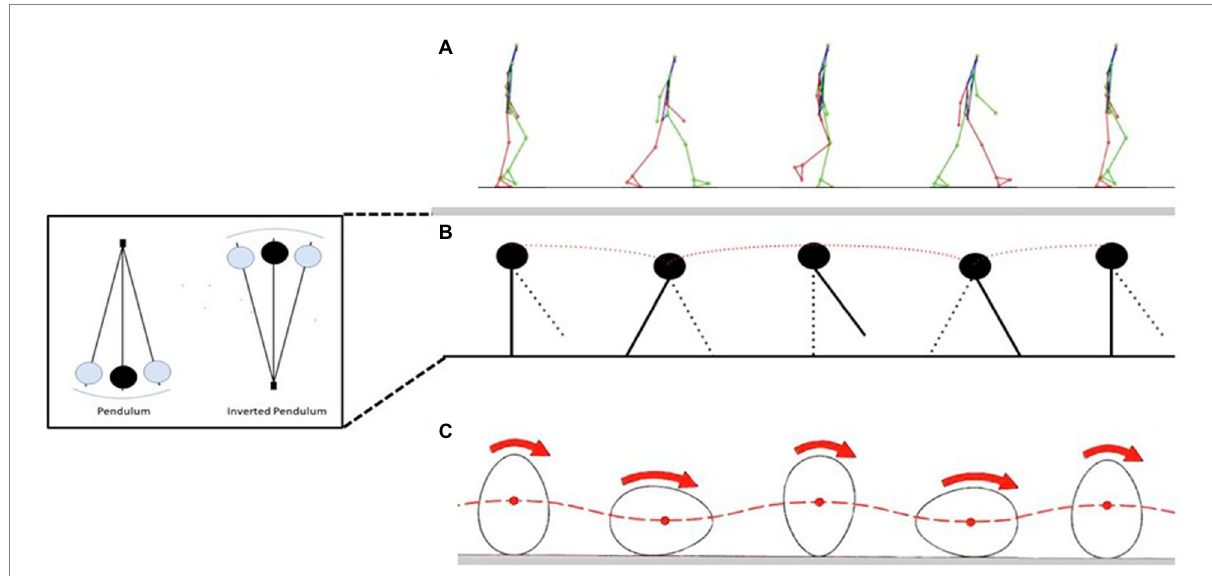
FIGURE 1 Gait cycle (A) depiction of the gait cycle from the single support of one foot to the next one. In the middle you can see: double support (second figure), single contralateral support and double support; when one limb is in single support, the other is in the swing phase. (B) “The inverted pendulum” the locomotor paradigm of the gait. The center of mass moves on arcs of circumference during the ground support phase as would a pendulum with a fulcrum on the floor (inset). In walking, the fulcrum on the ground is given by the foot, while the bar on which the center of mass is attached is the lower limb. The center of mass is at the apex of the trajectory during single support (the lower limb is extended and perpendicular to the ground), at the lower end during double support. (C) “The egg that rolls” the first paradigm used to describe the gait cycle. It can be seen how the center of mass of the egg moves from a higher to a lower position as the egg rotates [modified from Pavei (2019), with